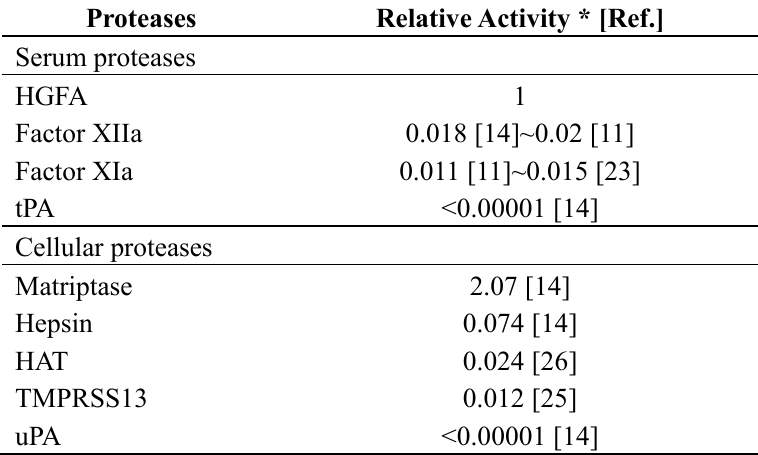
Table 1. HGF/SF-activating